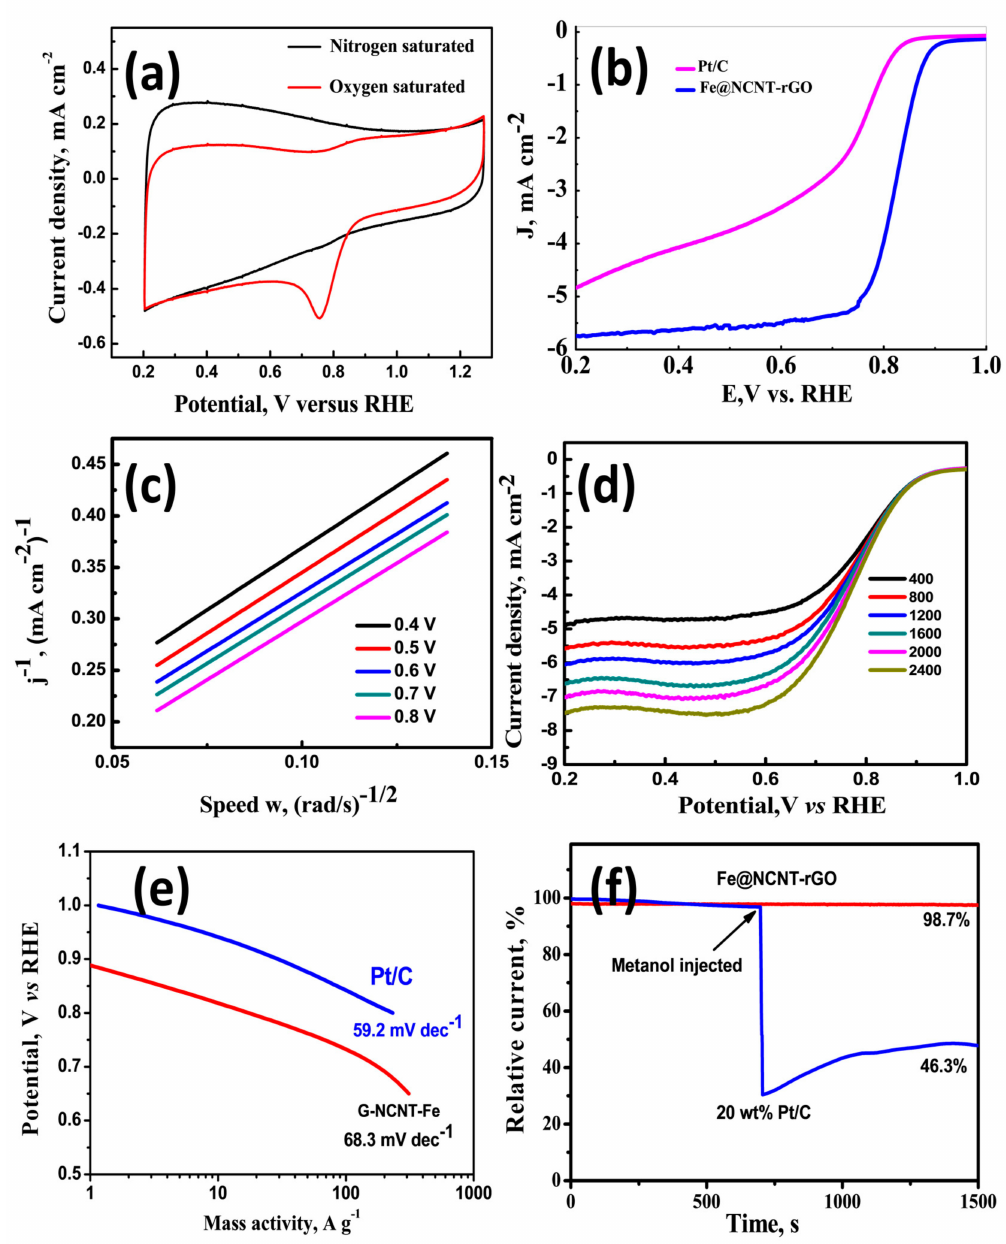
Figure 3. Current-Voltage curves of Fe@NCNT-rGO electrode in N 2 (black) and O 2 (red) saturated 0.1 M KOH electrolyte at a sweep rate of 50 mV s − 1 ( a ); Comparative Linear sweep